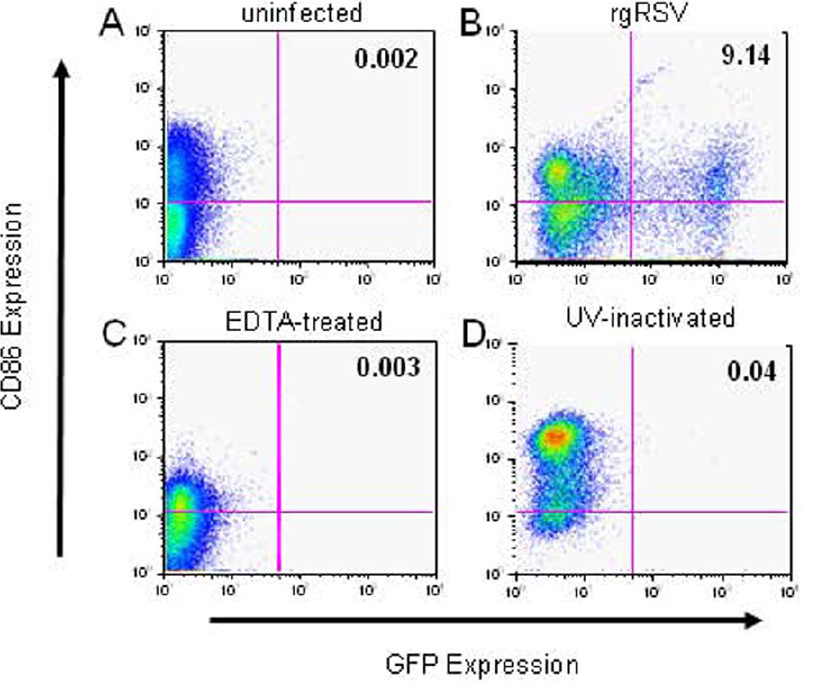
Figure 4. RSV infection of mDC1 requires divalent cations and viral replication, but maturation does not require replication. mDC1 were mock infected (panel A), or exposed to live RSV (panel B), RSV treated with 0.05 M EDTA (panel C), or UV-inactivated RSV (panel D). Equivalent viral particles (moi=5 of live virus) were used for each RSV exposure. Twenty-four hours after virus exposure the cells were stained for maturation markers (CD83, CD86, CD209) and analyzed by flow cytometry. GFP and CD86 expression is shown in a representative donor (of 8) in which both EDTA-treated and UV-inactivated RSV were used. Data for all donors are summarized in Table 1.